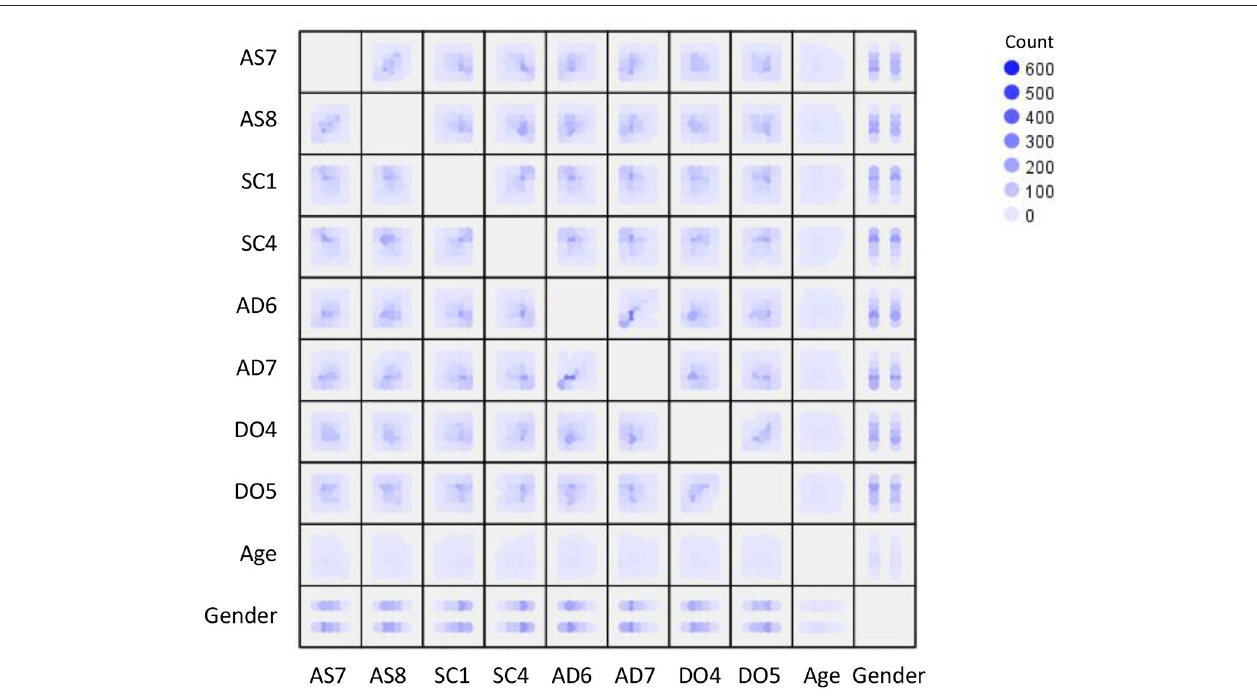
FIGURE 9 | Scatterplots with heat density for the variables in the DISC Personality Test. AS refers to assertiveness, SC refers to social confidence, DO refers to dominance, AD refers to